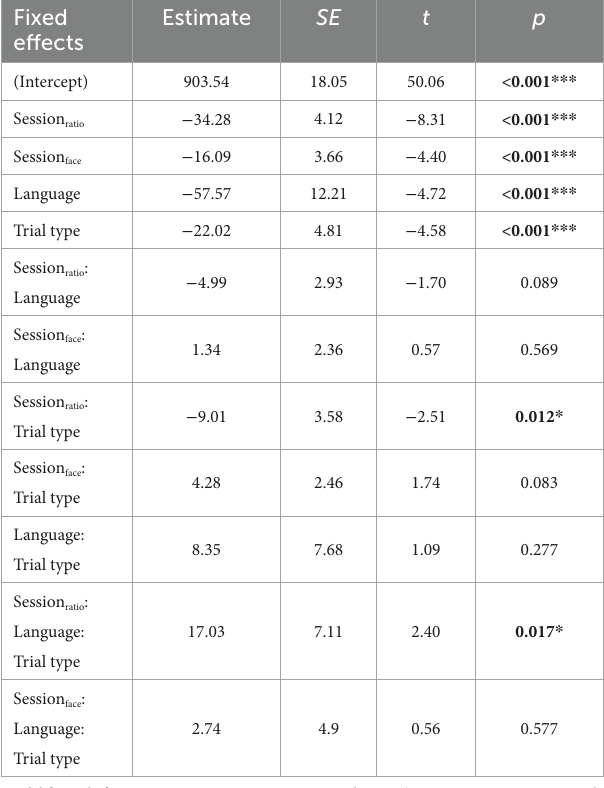
TABLE 2 Mixed-effects model for RT. Fixed